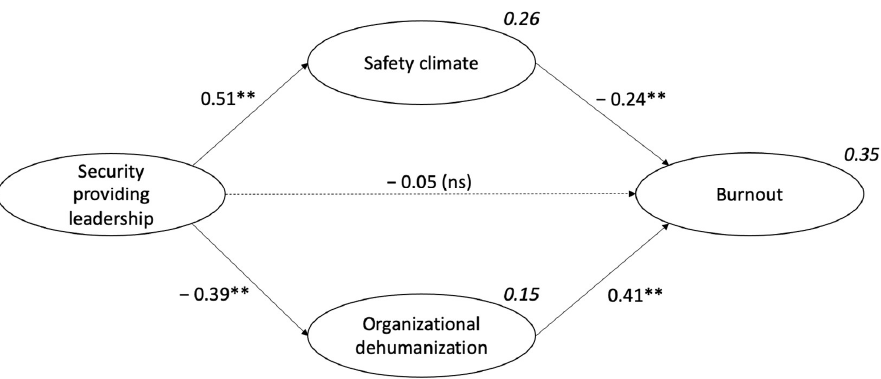
Figure 2. Standardized estimations for the full model. ** p < 0.01. Dotted lines show non-significant paths.